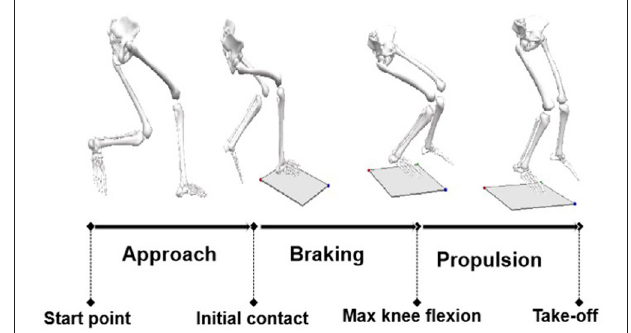
FIGURE 2 | The process of jump following a